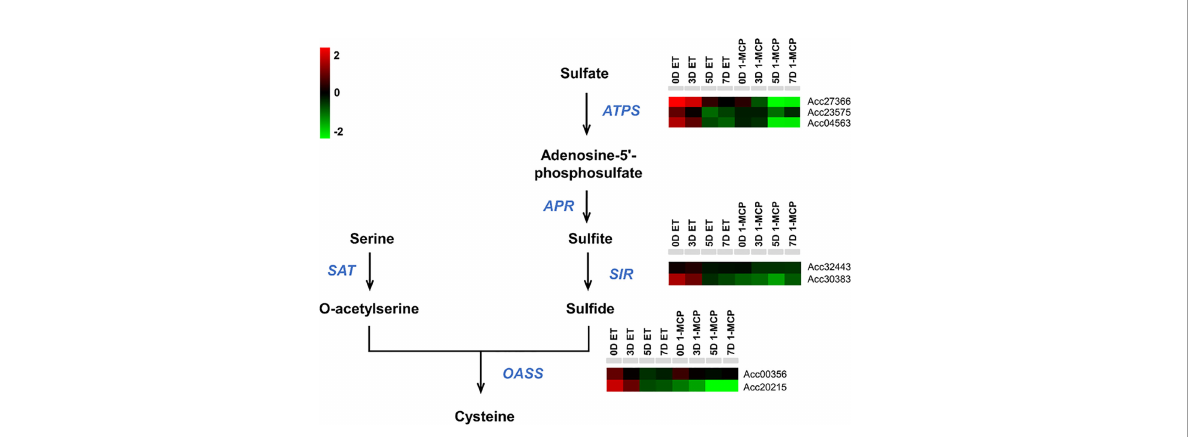
FIGURE 7 Expression pro fi les of cysteine biosynthesis pathway genes upon ET and 1-MCP treatment along ripening time course. Schematic diagram showing cysteine biosynthesis pathway from a precursor, sulfate. Gene names responsible for each step of the cysteine biosynthesis pathway were indicated with italicized blue-colored letters. Expression levels of genes related to each step of the cysteine biosynthesis pathway were presented as a heatmap. Red cube represents upregulated gene expression, and green cube represents downregulated gene expression compared to the level of the control sample. ET, ethylene; 1-MCP,